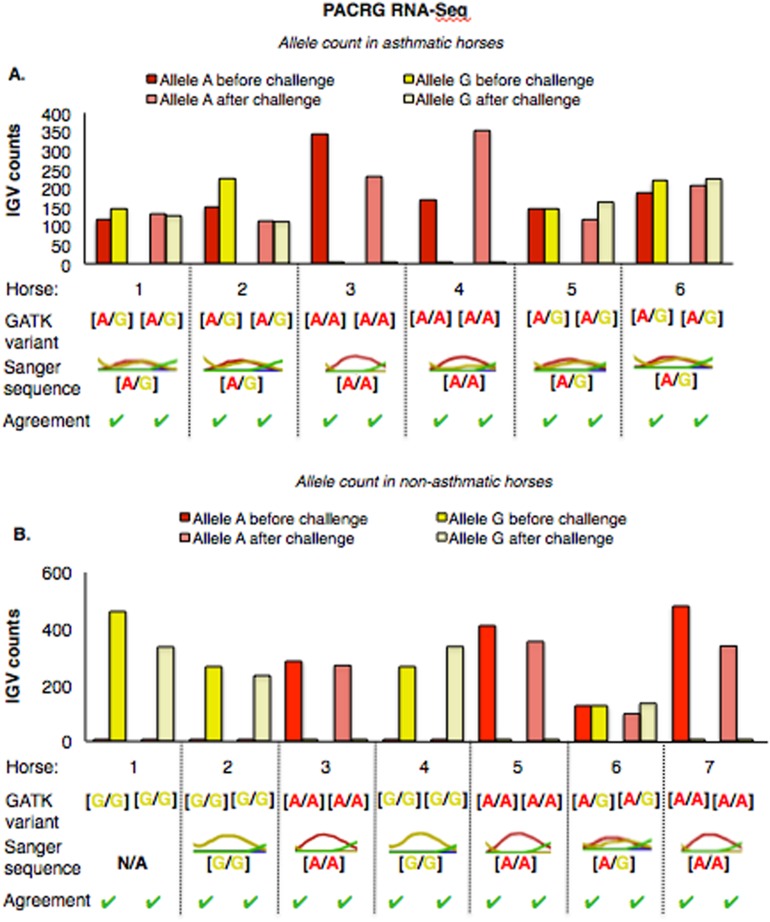
Comparison of GATK variant calls and Sanger sequencing results for PACRG in asthmatic (A) and non-asthmatic (B) horses.For both groups, the bar graph indicates the IGV count for each allele (A-red, G-yellow), horse and condition. Below the bar graph is the GATK variant call, the electropherogram of the Sanger sequence, and agreement. (A) Four asthmatic horses (1, 2, 5, 6) had heterozygous alleles [A/G] and two (3 and 4) were homozygous for the mutant allele [A/A]. (B) In non-asthmatic horses, one horse (6) had heterozygous alleles [A/G], three horses (1, 2, and 4) were homozygous for the wild-type allele [G/G] and three horses (3, 5, and 7) were homozygous for the mutant allele [A/A]. All genotypes were consistent across horses and methods. DNA was not available for non-asthmatic horse 1.